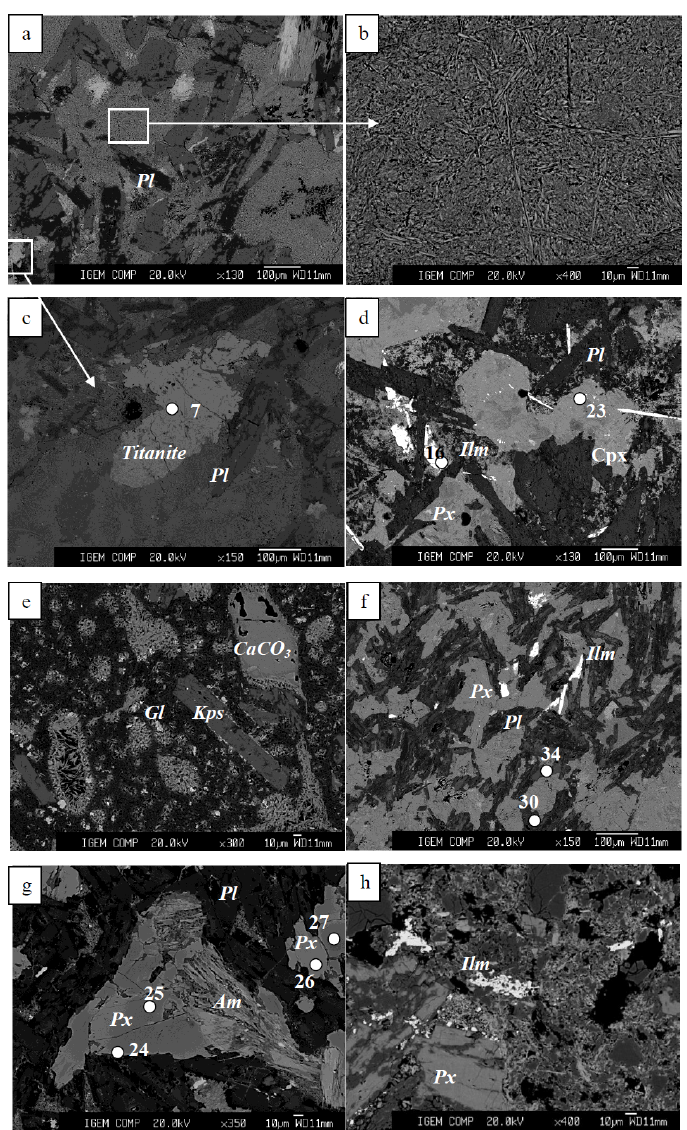
Figure 8. BSE images of volcanic rocks from the Khalil site ( a – e ) Syverminsky formation: a–c: basalt, sample X-20: ( a ) tholeiitic texture, ( b ) devitrified glass under high magnification, details of Figure 8a, ( c ) titanite grain, detail of Figure 8a; ( d ) basalt, sample X-10; ( e ) tuff, sample X-37; ( f , g ) Gudchikhinsky formation; ( h ) Khakanchansky formation, tuff, sample X-0; No point corresponds to the number in Table 1; Minerals: Pl : plagioclase, Px : pyroxene, Ilm : ilmenite; Gl : glass, Am : amphibole; Kps : potassium feldspar). Scale bars, µm: a, c, d, f—100; b, e, g, h—10.